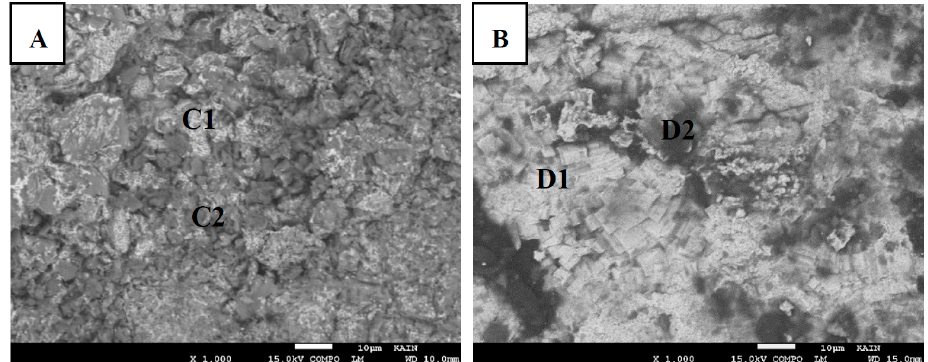
Materials 2019 , 12 , x FOR PEER REVIEW Figure 8. The fractured surfaces of bond made at 20 min. ( A ) Mg side. ( B ) Ti side. Table 2. Corresponding EDS weight/atomic composition for Figure 8.